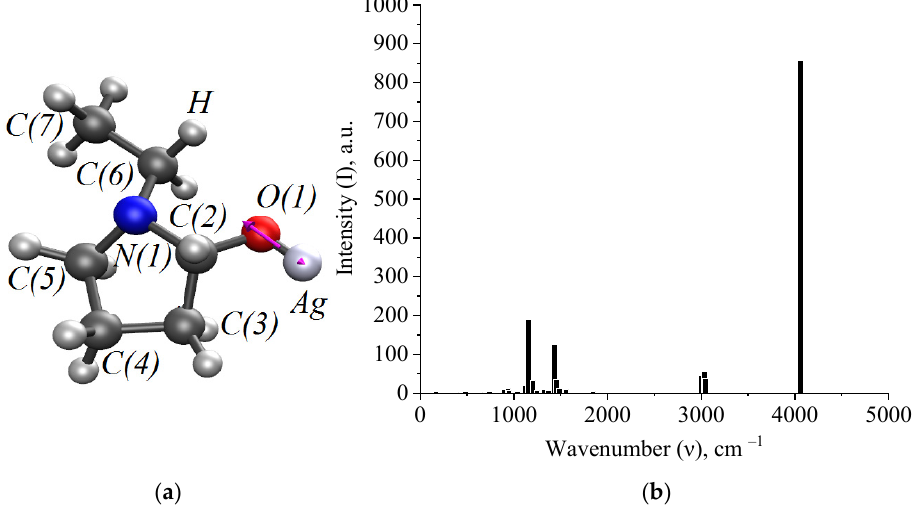
Figure 10. Modeling of spectral characteristics of Ag ‐ PVP molecular complex (interaction through oxygen): ( a )—the oscillation of the O ‐ Ag bond and ( b )—the IR spectrum.